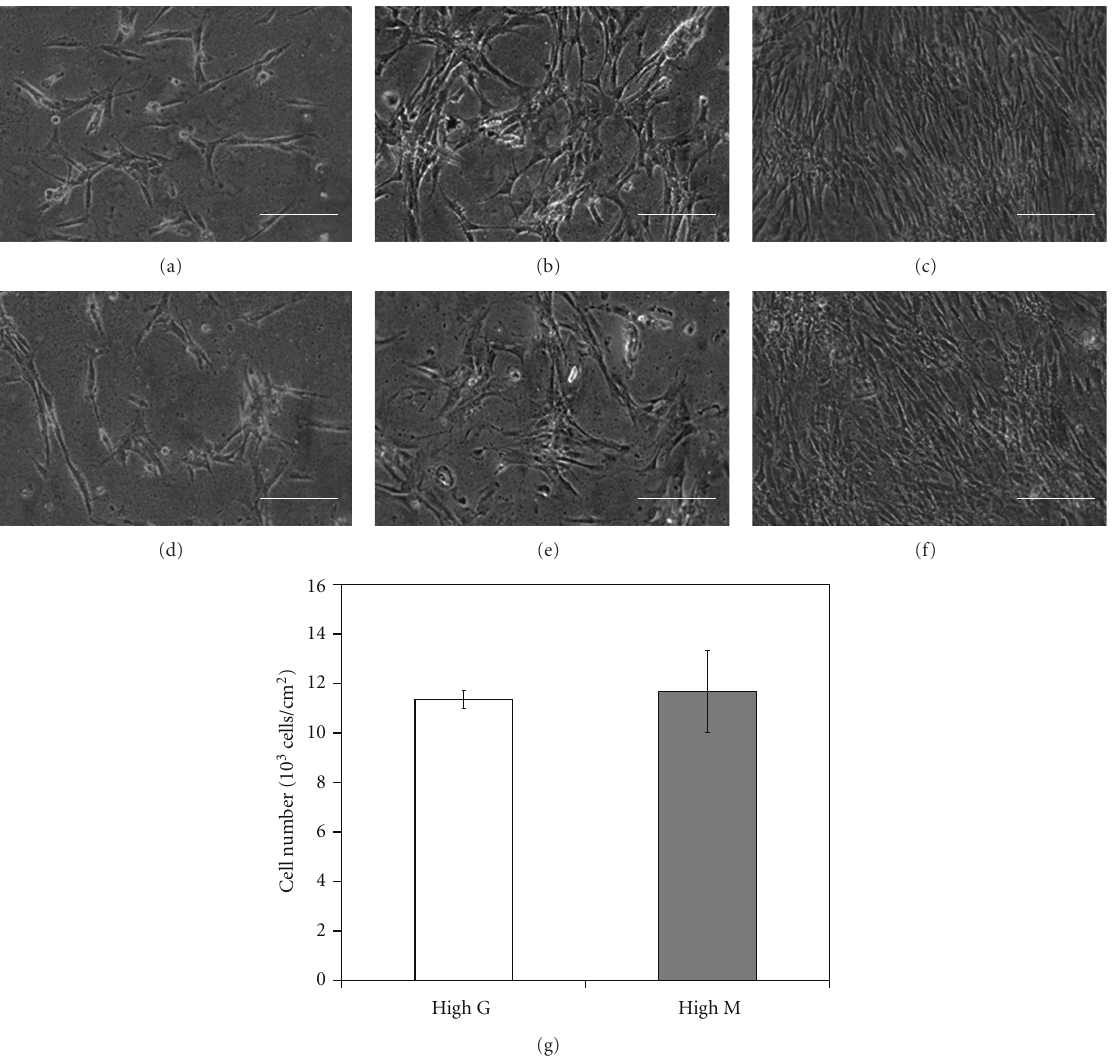
Figure 5: Proliferation of NHDF on Fe-alginate film under stable gel conditions. Cells were seeded onto high-G (a–c) and high-M (d–f) alginate films that had been immersed in culture medium for 8 days to stabilize the gel properties. Phase-contrast micrographs were taken at 1 day (a, d), 5 days (b, e), and 8 days (c, f) after cell seeding. Bar equals 200 μ m. The numbers of attached cells on the films were counted after incubation for 8 days